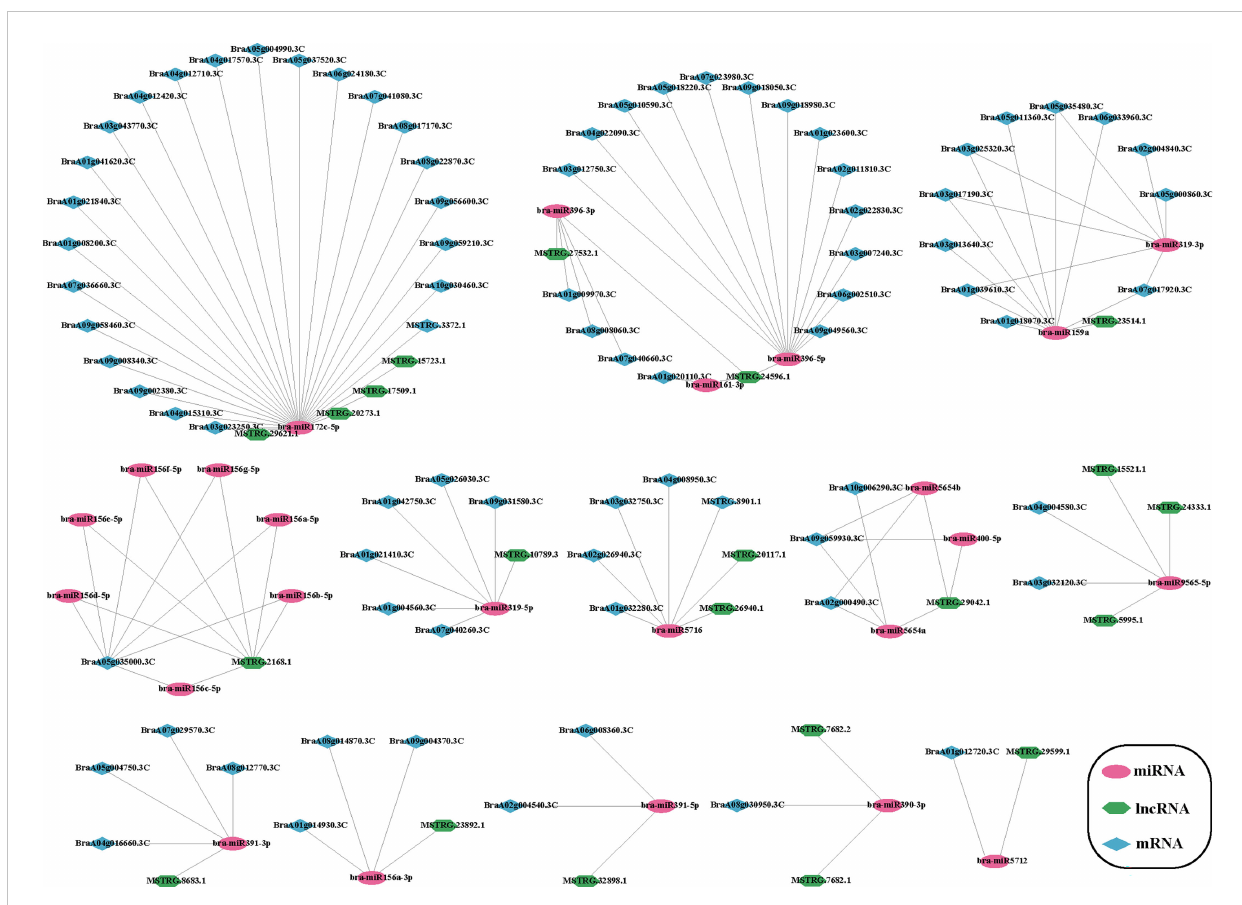
FIGURE 8 Plumule-vernalization response ceRNA network of Chinese cabbage. The red oval, purple hexagon, and blue diamond nodes represent miRNAs, DE lncRNAs, and DE mRNAs,